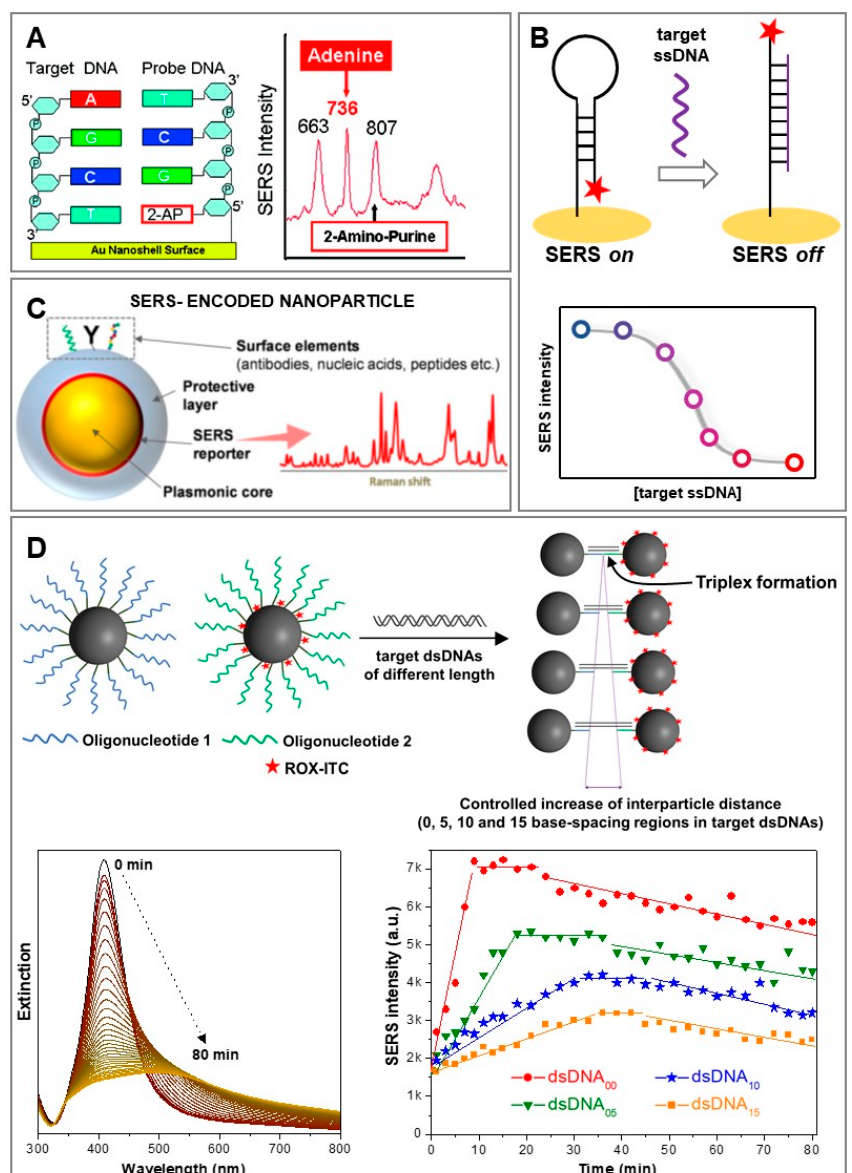
Figure 3. ( A ) Depiction of the label-free sensing scheme for monitoring DNA hybridization: a thiolated oligonucleotide (DNA probe), with 2-aminopurine (2-AP) substituted for adenine, A, is anchored onto a gold nanoshell surface. Upon hybridization with the complementary target DNA, a new adenine band arises in the SERS spectrum. Adapted with permission from [52]. Copyright 2010, American Chemical Society. ( B ) Illustration of a canonical hairpin DNA probe equipped with a SERS label for on-off detection and quantification of the target strand. ( C ) Schematic of a typical SERS-encoded particle. Adapted with permission from [17]. Copyright 2017, Springer. ( D ) Outline of the duplex-mediated assembly of two sets of silver nanoparticles functionalized with triplex-forming oligonucleotides (one of the two batches of nanoparticles was also labelled with carboxy-X-rhodamine isothiocyanate, ROX-ITC, as the SERS code); head-to-head nanoparticle triplex assembly was initiated by the addition of complementary dsDNA of increasing length (dsDNA 00 , dsDNA 05 , dsDNA 10 , and dsDNA 15 ). Extinction spectra in the absence (black line) and after the addition of complementary dsDNA between 0–80 min, at 150 s intervals. Time-dependent values of ROX-ITC SERS intensity (peak height of the 1646 cm − 1 band) for each dsDNA-mediated nanoparticle assembly during the aggregation process. Adapted with permission from [56]. Copyright 2012, Royal Society of